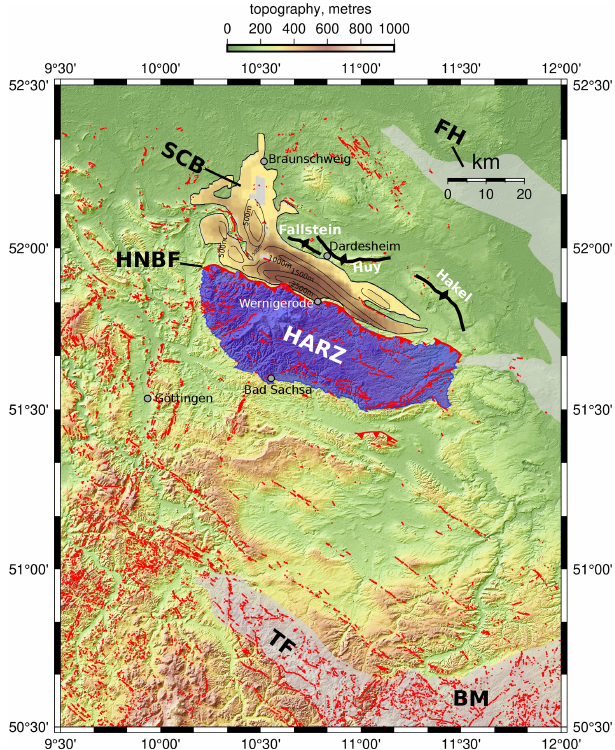
Figure 2. Overview of the Harz Mountains and the Subhercynian Cretaceous Basin (SCB), showing the positions of the northern bounding structures of the SCB (Fallstein–Huy–Hakel anticlines). The SCB outline is adapted from the Southern Permian Basin At- las (Doornenbal and Stevenson, 2010). Contours of Late Cretaceous total thickness are from Voigt et al. (2008). Abbreviations: SCB – Subhercynian Cretaceous Basin; FH – Flechtingen High; HNBF – Harz Northern Boundary Fault; TF – Thuringian Forest Basement Uplift; BM – Bohemian Massif. Topography is from EU-DEM v1.0 (Mouratidis and Ampatzidis, 2019). Faults are from GÜK200 (Zitz- mann,